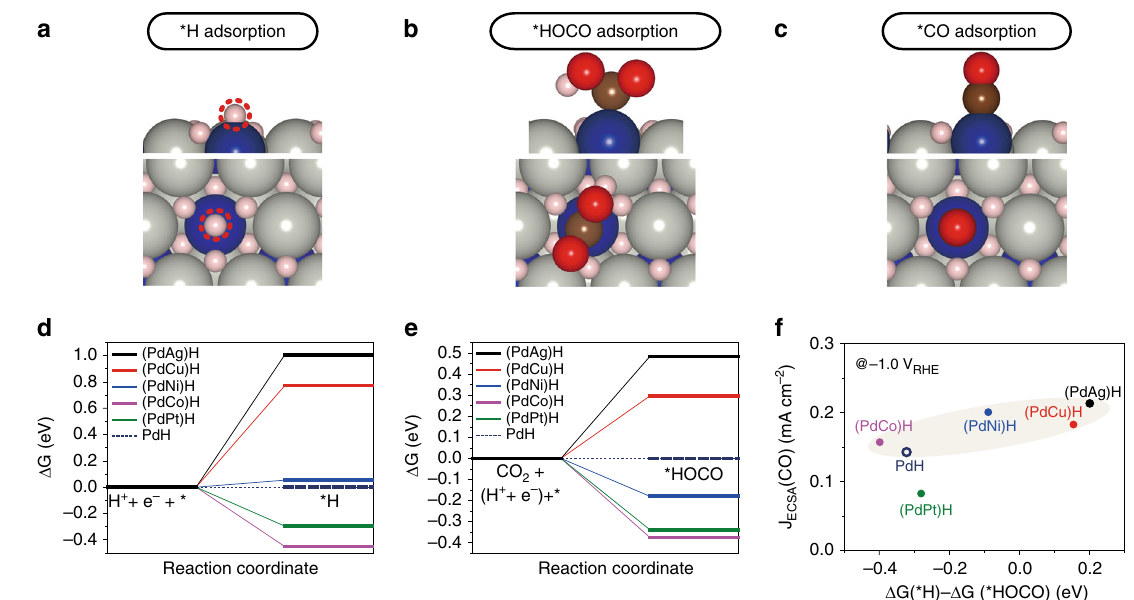
Fig. 4 Density functional theory results. a – c DFT optimized con fi gurations of a *H, b *HOCO, and c *CO adsorption on (PdM)H. Pd (gray), M (blue), O (red), and H (pink). *H is shown within dotted red circle in ( a) . d , e The changes in free energy ( Δ G) for the rate limiting steps in e HER and e CO 2 RR. f A plot of the free energy difference of *H and *HOCO adsorptions ( Δ G (*H) − Δ G (*HOCO)) versus J ECSA (CO) at − 1.0 V